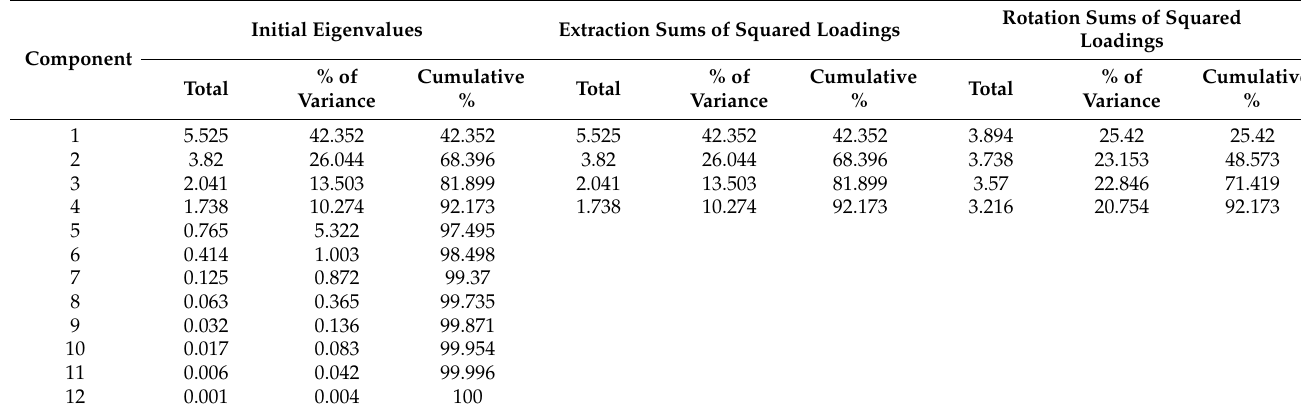
Table 4. Total variance explained.